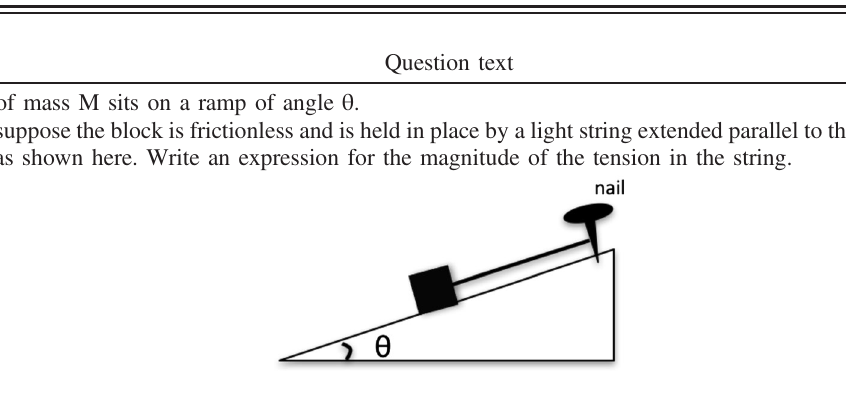
TABLE III. The isomorphic calculation questions and associated standard